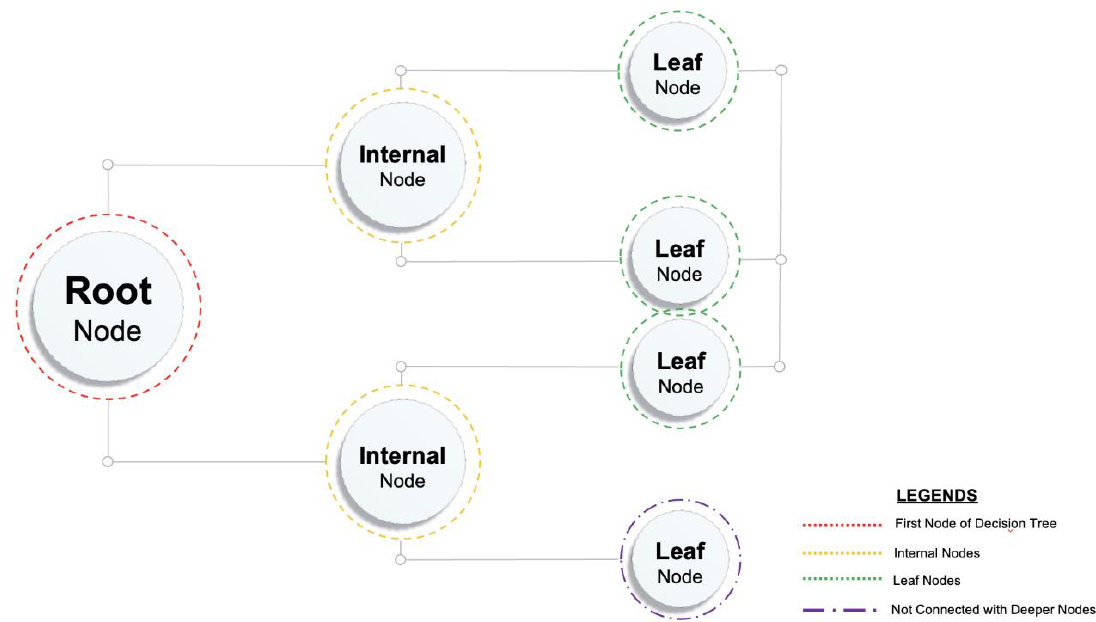
Figure 4. Decision tree schematic diagram.